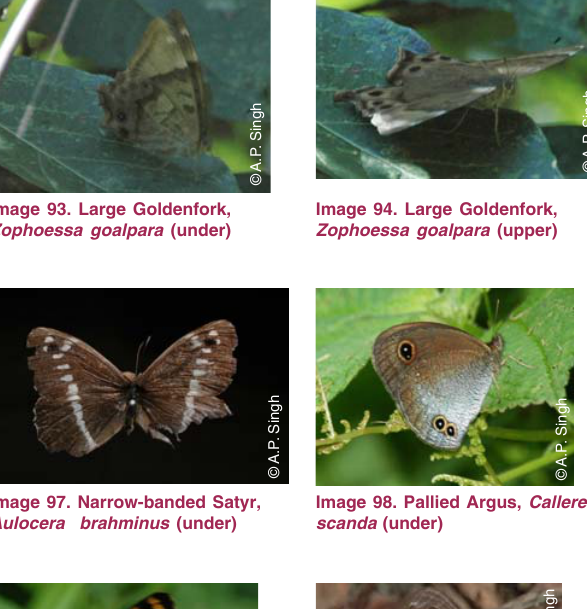
Image 97. Narrow-banded Satyr, Aulocera brahminus (under)